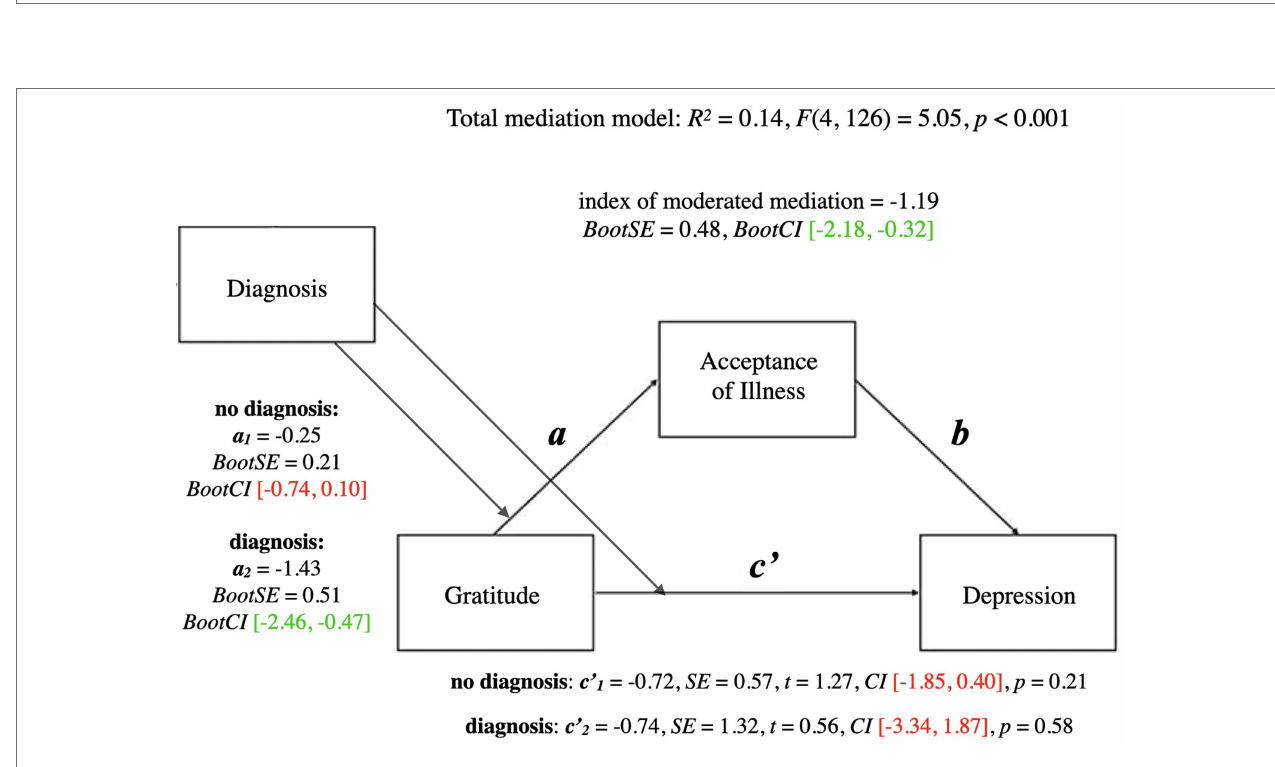
FIGURE 6 | Moderated mediation model for gratitude and depression with diagnosis as moderator. a, conditional indirect effect of gratitude on wellbeing through acceptance of illness; c', conditional direct effect of gratitude on wellbeing index of moderated mediation = difference between conditional indirect effects CI marked green indicate significance; red – lack of